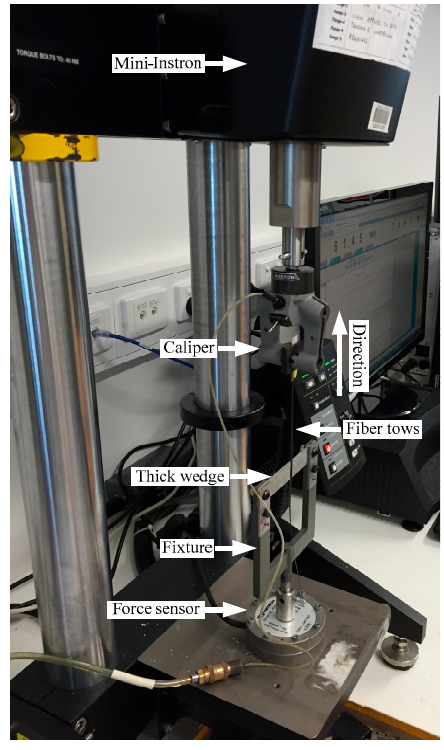
Figure 11. The platform for the peeling test.